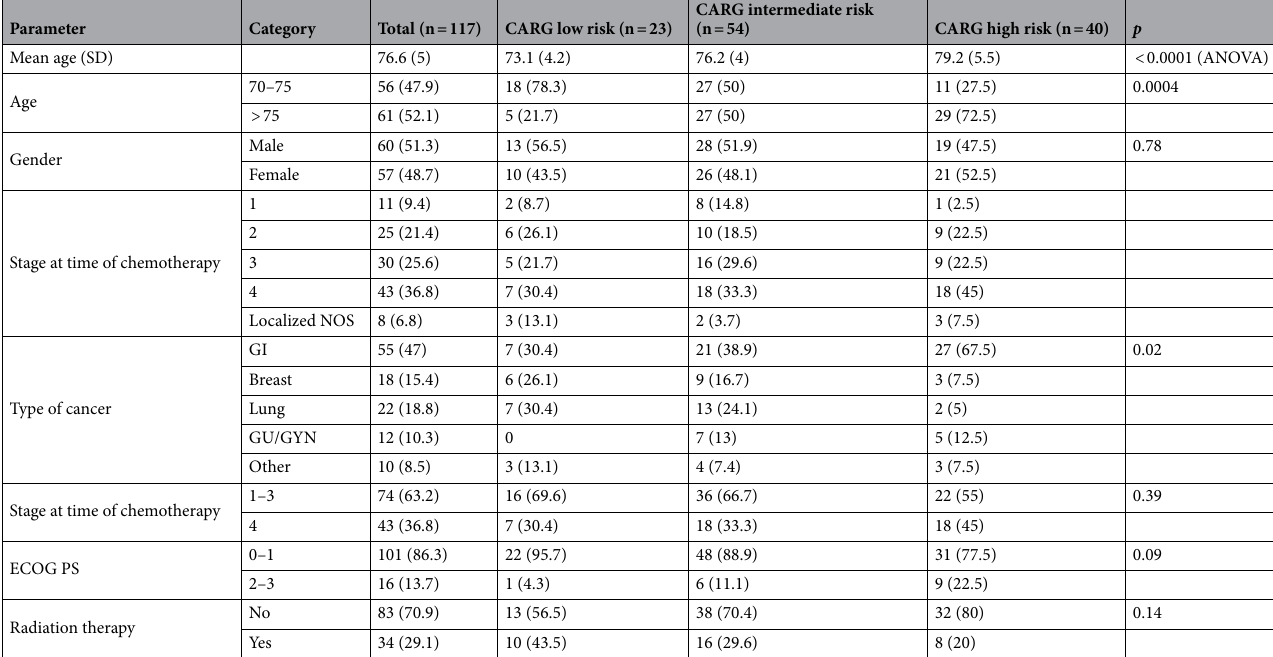
Table 4. Baseline patient characteristics according to the CARG risk groups. Percentages are in parentheses.